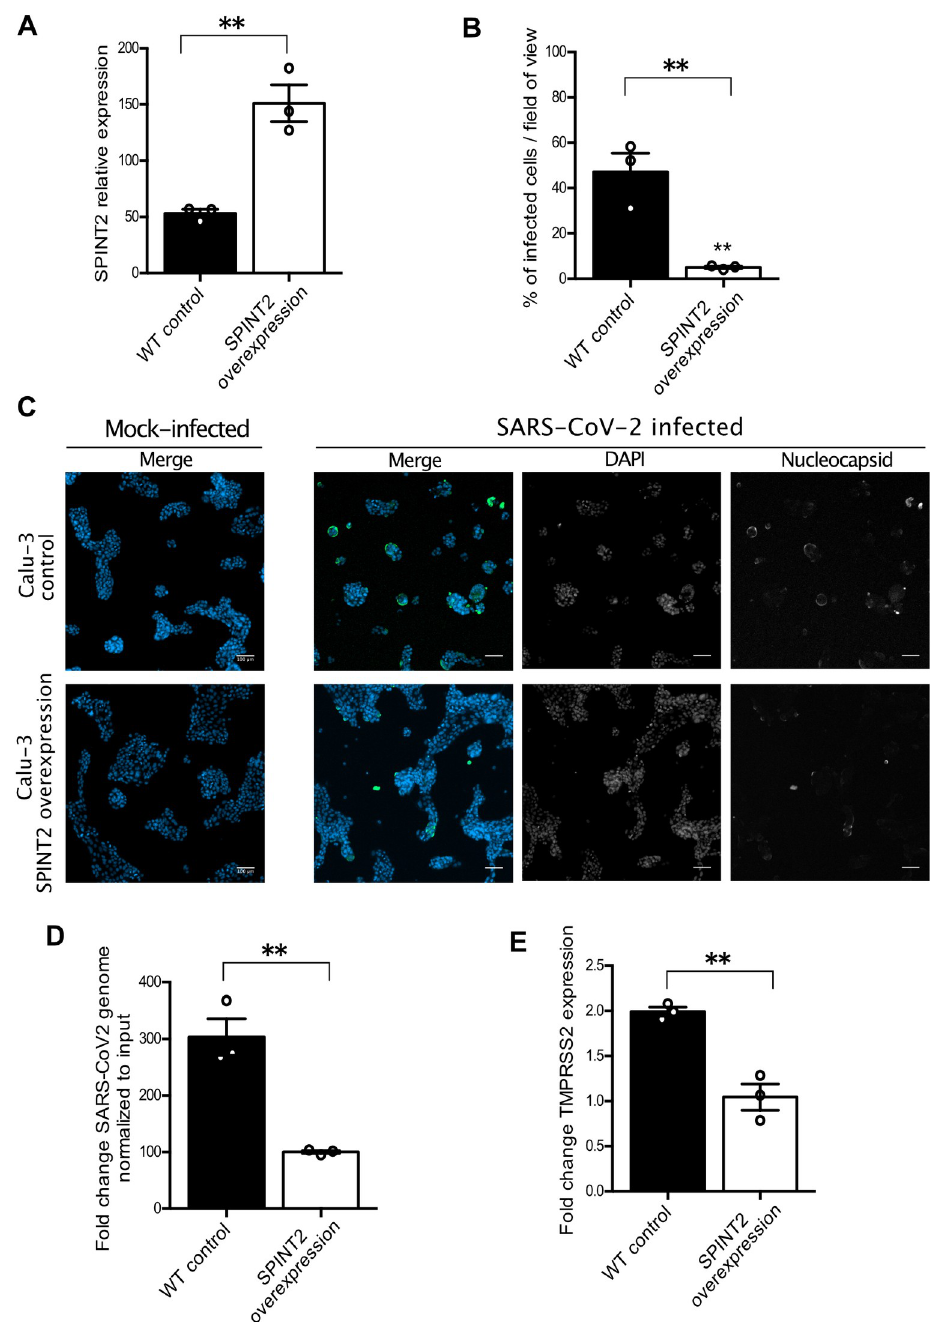
Fig 4. SPINT2 overexpression in Calu-3 cell lines negatively impacts SARS-CoV-2 infection. A . Relative expression of SPINT2 normalized to the housekeeping gene TBP in empty vector control and SPINT2 overexpressing Calu-3 cells. B. Quantification of the percentage of infected cells in Calu-3 cell lines transfected with an empty vector or a vector overexpressing SPINT2 for mock-infected and SARS-CoV-2 infected conditions. C. Representative immunofluorescence images of the infected cells quantified in B. Infection was detected by indirect immunofluorescence against the nucleocapsid N (green) and Nuclei were stained with DAP (blue). D. Quantification of SARS-CoV-2 replication. RNA was harvested at 24 hpi, and q-RT-PCR was used to evaluate the copy number of the SARS-CoV-2 genome. Data are normalized to inoculum used for infection. E. Relative expression of TMPRSS2 normalized to that of the respective mock-treated cells in empty vector control and SPINT2 overexpression Calu-3 cells. Error bars indicate standard deviation. n = 3 biological replicates. P < 0.05 � , P < 0.01 �� , P < 0.001 ��� , P < 0.0001 ���� . Analysis was done by a two-tailed unpaired t-test with Welch’s